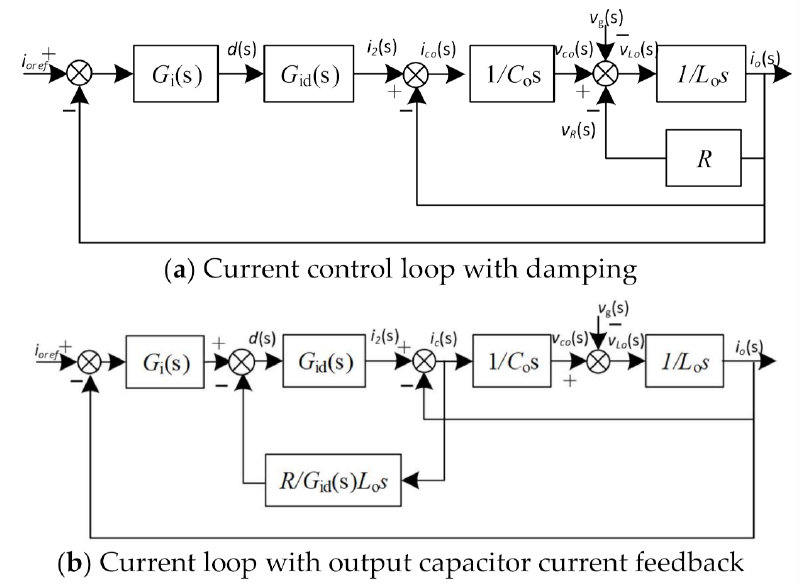
Figure 13. Block diagram of output current closed-loop control with LCR filter.